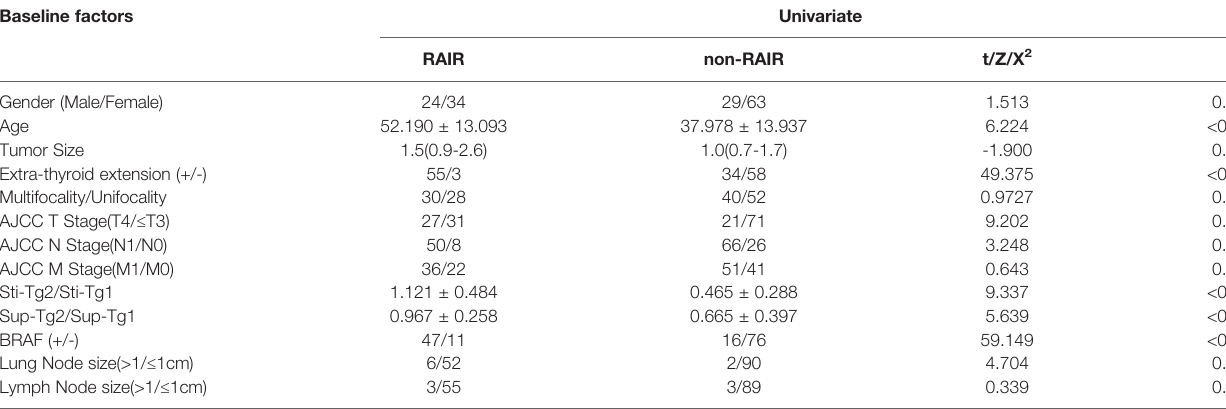
TABLE 2 | Univariate analysis of the factors in the TgAb negative group. Baseline factors